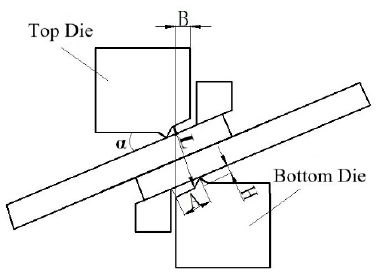
Figure 1. Shear connection diagram.